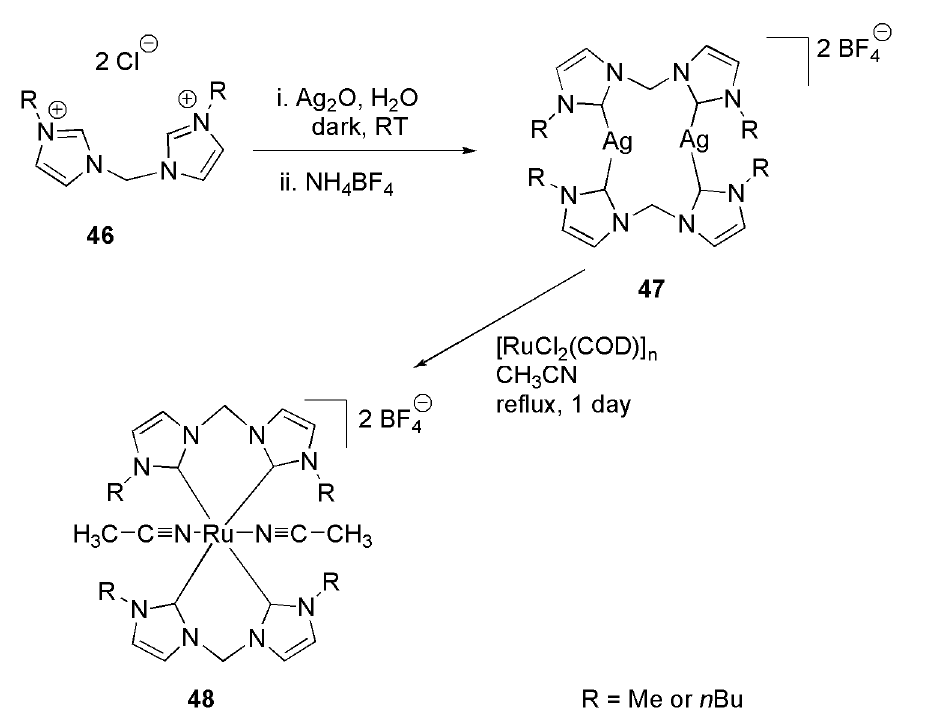
Scheme 14. Bis ‐ NHC and its ruthenium complexes [125]. Scheme 14. Bis-NHC and its ruthenium complexes [125].